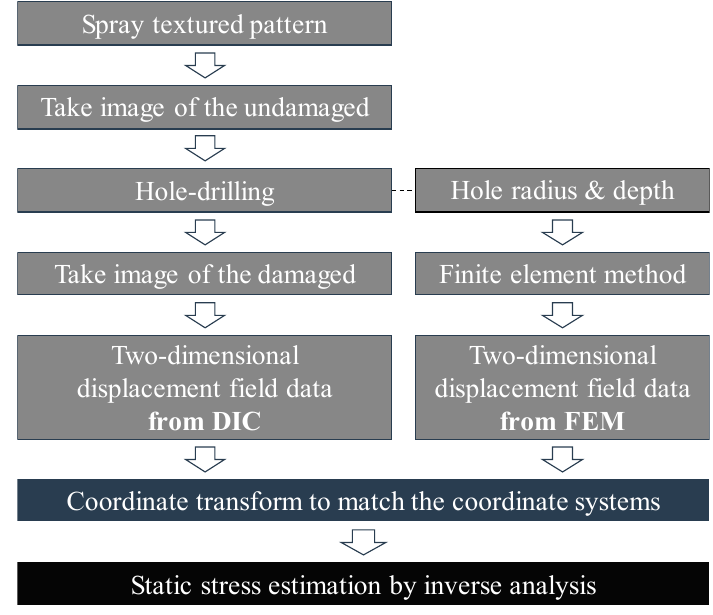
Figure 1. Flowchart of the algorithm used for the static stress estimation.